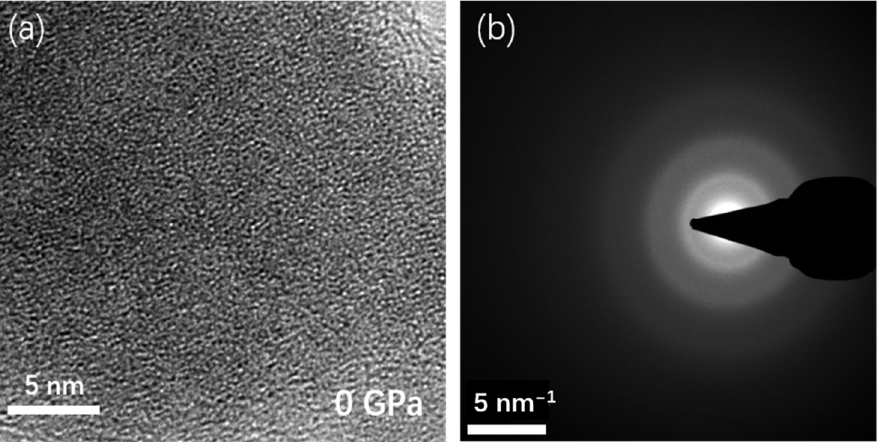
Figure 4. Structural characterization of amorphous Ge used in non-hydrostatic compression. ( a ) HRTEM image and ( b ) the selected area electron diffraction (SAED) indicate that the original sample is fully amorphous.